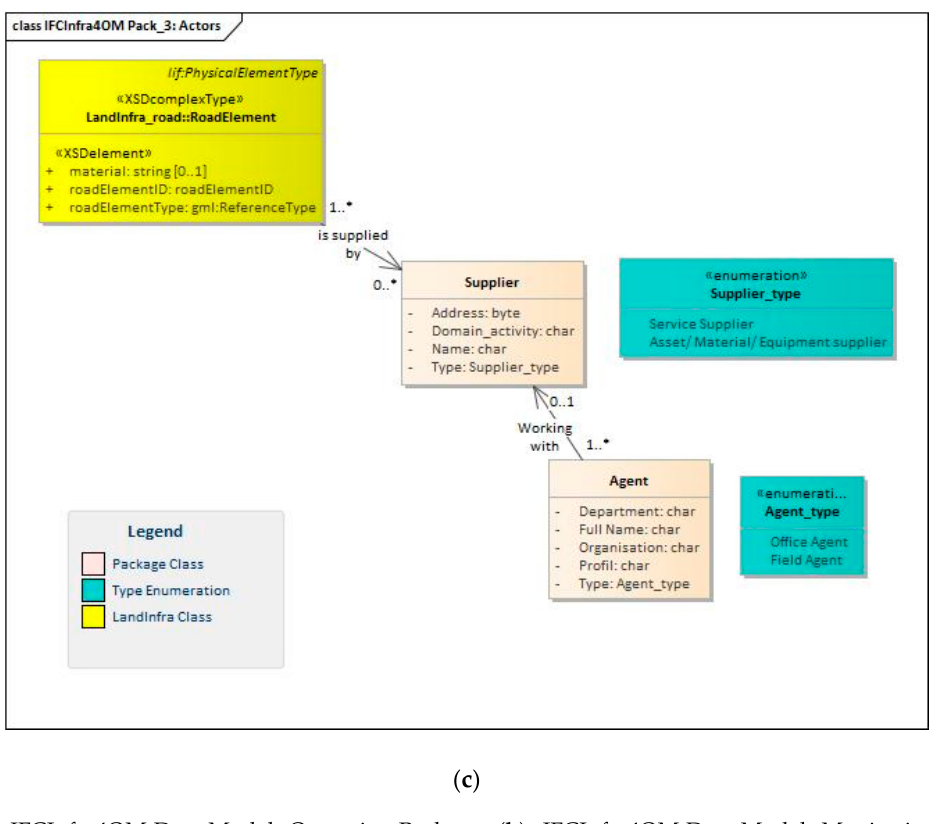
Figure 5. ( a ). IFCInfra4OM Data Model: Operation Package. ( b ). IFCInfra4OM Data Model: Monitoring Package. ( c ). IFCInfra4OM Data Model: Actor Package.